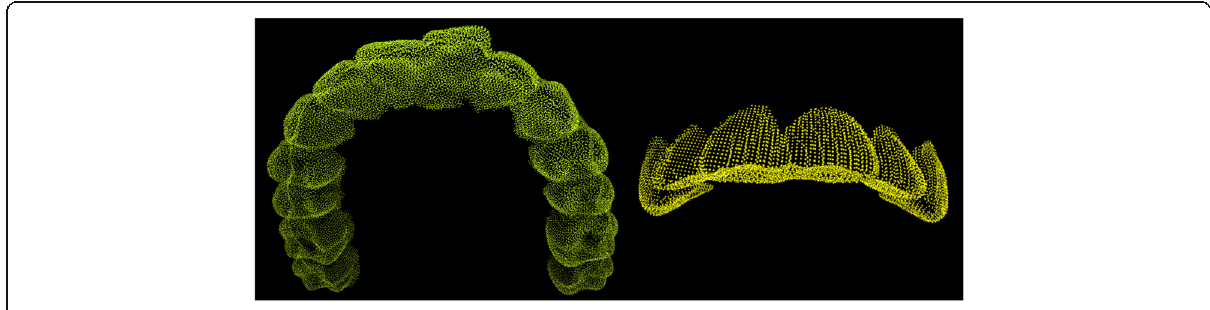
Fig. 1 Preview of the point clouds of the 3D dataset of dental casts